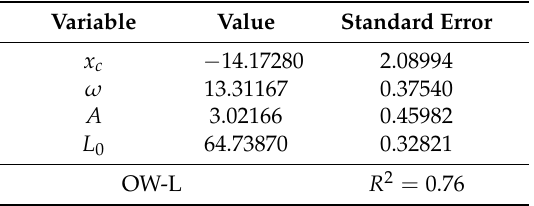
Table 15. Correlation modeling between Relative Humidity and Noise Level at OW-L.